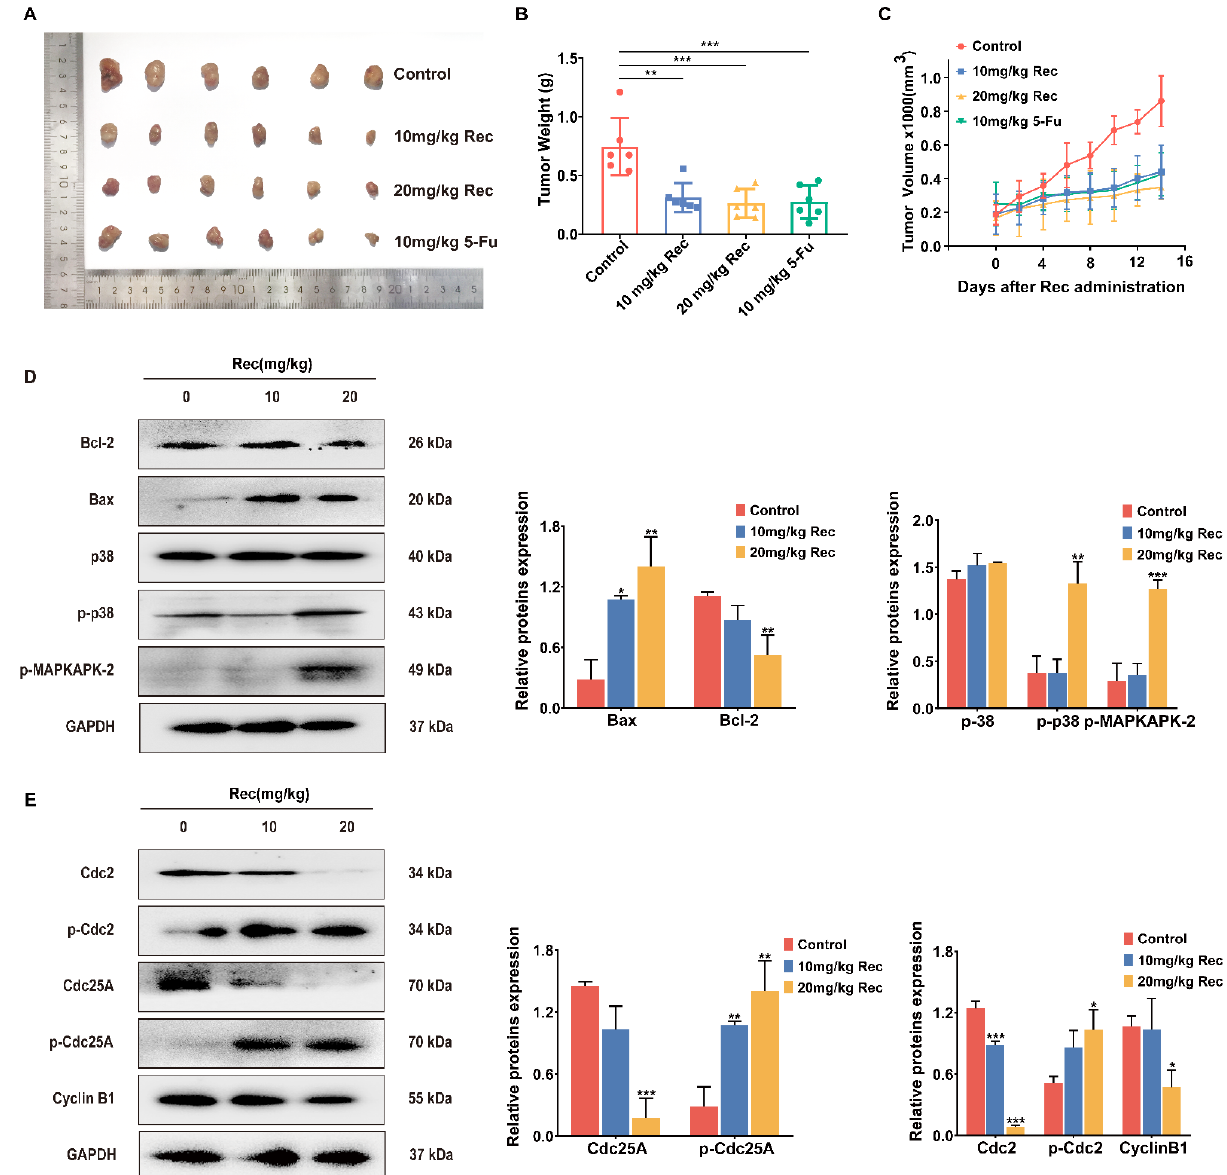
Figure 6. Resistomycin resulted in apoptosis and G2/M phase arrest by activating p38 MAPK signaling in vivo. ( A ) Images of transplanted HepG2 tumors treated with solvent, resistomycin (10 and 20 mg/kg) and 5-Fu (10 mg/kg). ( B ) Tumor weight changes with treatment. ( C ) Curve of tumors indicating that resistomycin effectively controls the growth of xenograft tumors. ( D ) Relative protein expression related to apoptosis, cell cycle arrest and the p38 MAPK pathway in HepG2 tumors. * p < 0.05, ** p < 0.01 and *** p < 0.001 versus 0 mg/kg